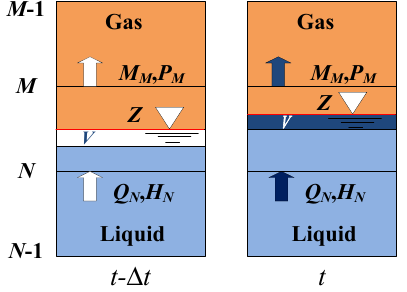
Figure 23. Coupling between liquid and gas